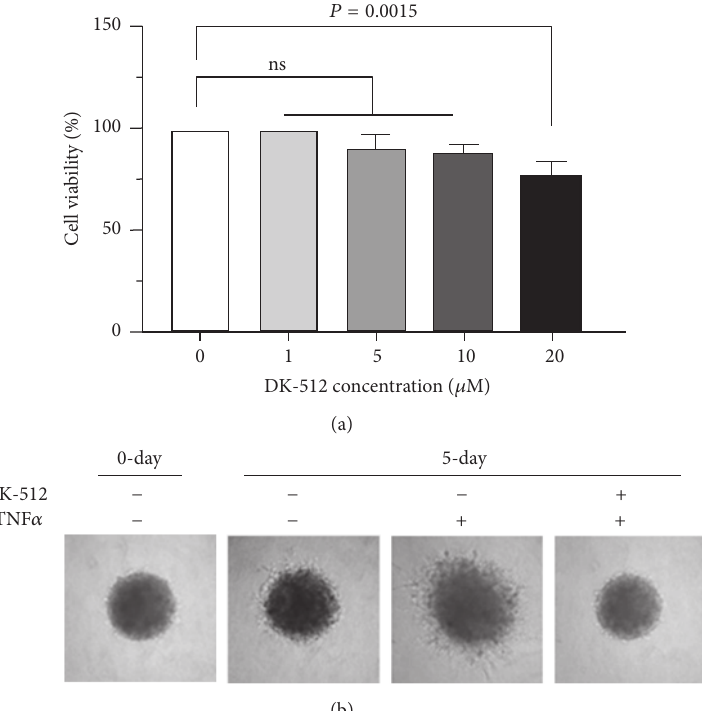
Figure 2: Effect of DK-512 on cell viability. (a) Cytotoxicity of DK-512. MDA-MB-231 cells were treated with different concentrations of DK- 512 (0, 1, 5, 10, and 20 𝜇 M) for 24 h. Cell viability was determined using the Cell Counting Kit-8 (CCK-8). The data shown represent the mean ± SD ( 𝑛 = 3 ). ns: not significant; P value was analyzed by Sidak’s test. (b) 3D invasion assay. MDA-MB-231 cell spheroid in the extracellular matrix was either left untreated or treated with TNF 𝛼 (10ng/mL) in the absence or presence of 5 𝜇 M DK-512. Morphology of invasive spreads was captured with an EVOS FL Auto Cell Imaging